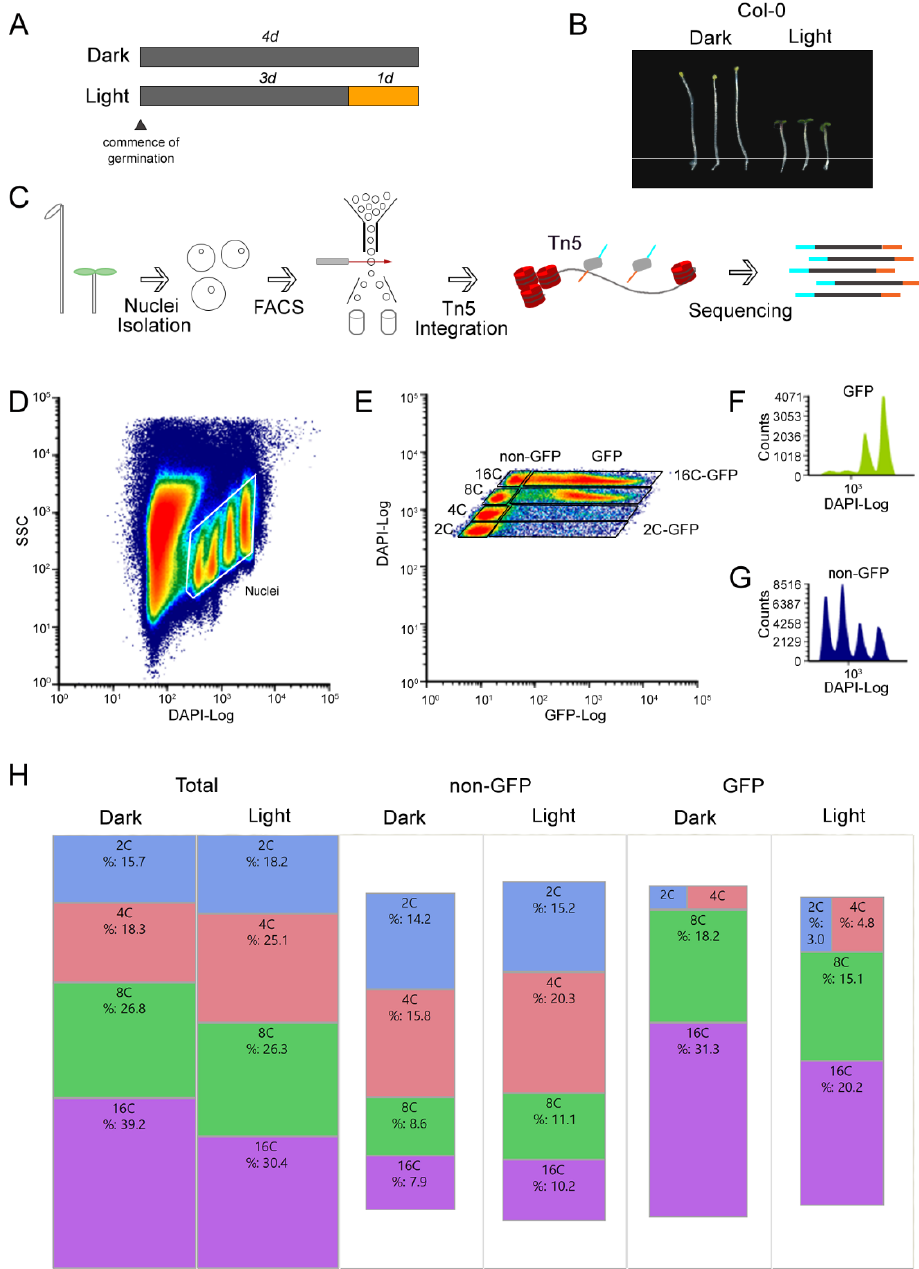
Figure 1. Endopolyploidy levels increase in dark-grown hypocotyls specifically in the epidermal layer. ( A ) Experimental design for light and dark-grown hypocotyls. ( B ) Representative images of light- and dark-grown Col-0 hypocotyls. ( C ) Workflow of fluorescence activated nuclei sorting (FANS) combined with the assay for transposase-accessible chromatin using sequencing (ATAC-seq). ( D ) Bivariate density histogram of the initial gate used to separate nuclei from major debris. See methods for further channel clean up. ( E ) Bivariate density histogram of the final gates used for sorting after clean-up for all endoploidy regions. ( F ) DAPI signal for all nuclei expressing the GFP marker. ( G ) DAPI signal for all nuclei not expressing the GFP marker. ( H ) TreeMap view of the percentage of nuclei for each endoreduplication level for a typical sort. The size of the rectangles is proportional to the sample